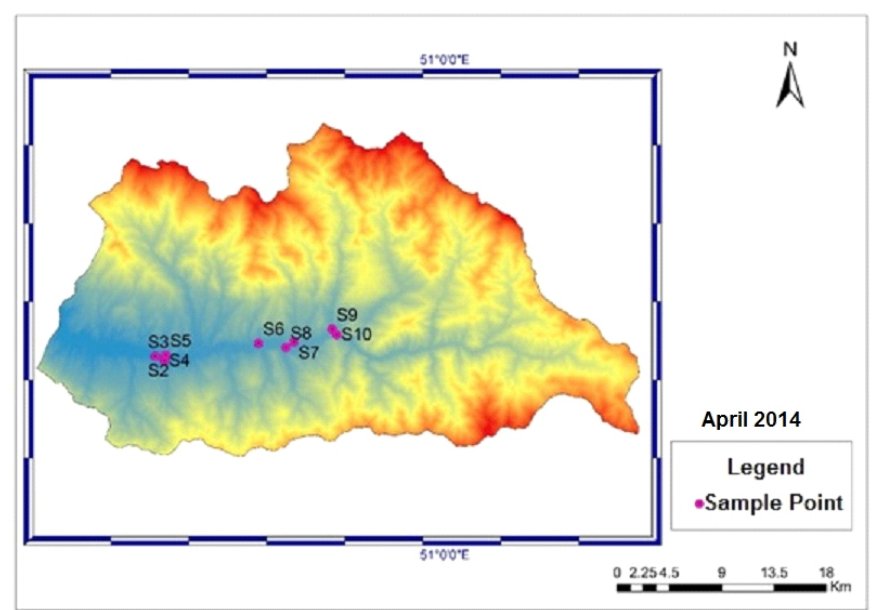
Fig. 2: spatial position of sediment sample points in Taleghan